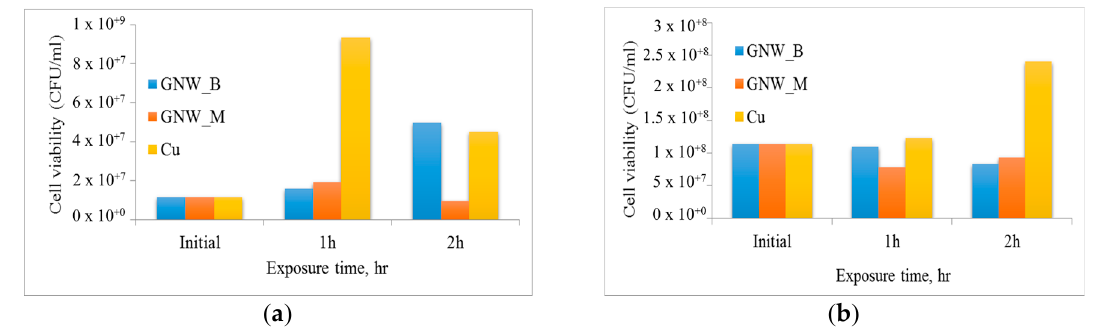
Figure 5. The survival rate of ( a ) E. coli and ( b ) S. aureus bacteria when exposed to graphene fabricated from methane (GNW_M) and bagasse (GNW_B), and a pure copper substrate.